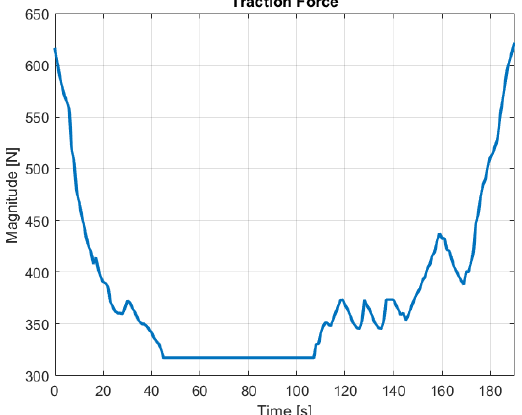
Figure 7. Vehicle traction force for the general driving cycle.